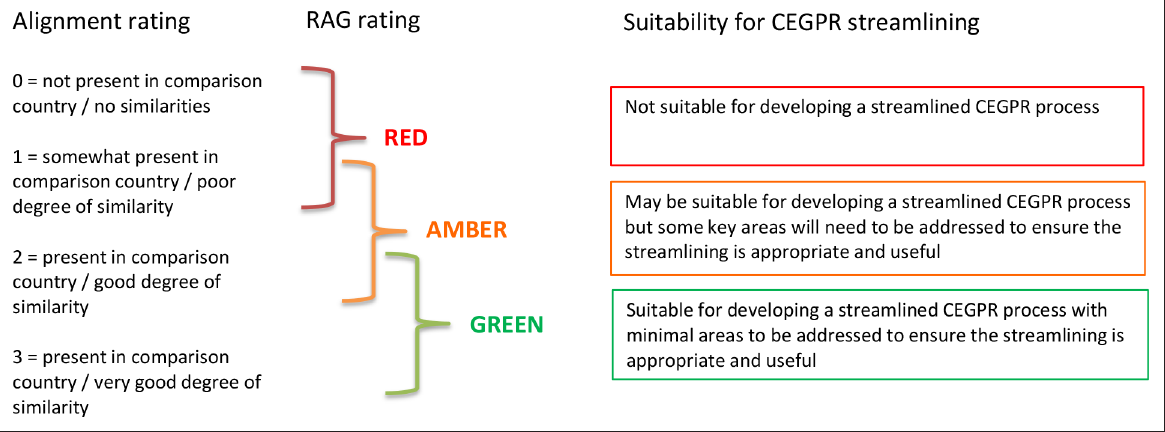
Figure 2 Guidance for applying an alignment rating, RAG rating, and what these mean regarding suitability for CEGPR streamlining CEGPR = Certificate of Eligibility for General Practice Registration. RAG = red, amber,